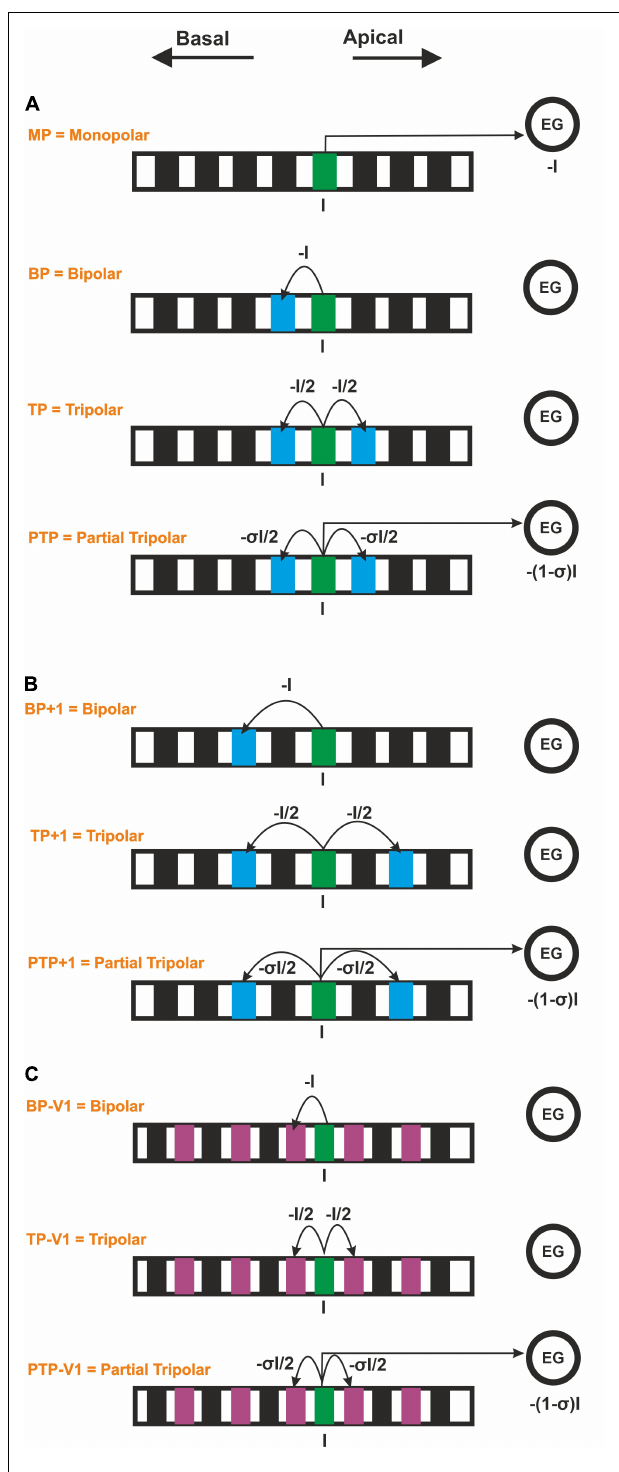
FIGURE 3 | Forced current flow (I) from the stimulating CI channel for monopolar, bipolar, tripolar, and partial tripolar configuration. (A) Monopolar strategy and multipolar strategies by considering the basal adjacent channel. (B) Multipolar strategies by considering the second basal adjacent channel in perimodiolar CI. (C) Multipolar strategies by considering a shorter interchannel distance in the lateral CI.